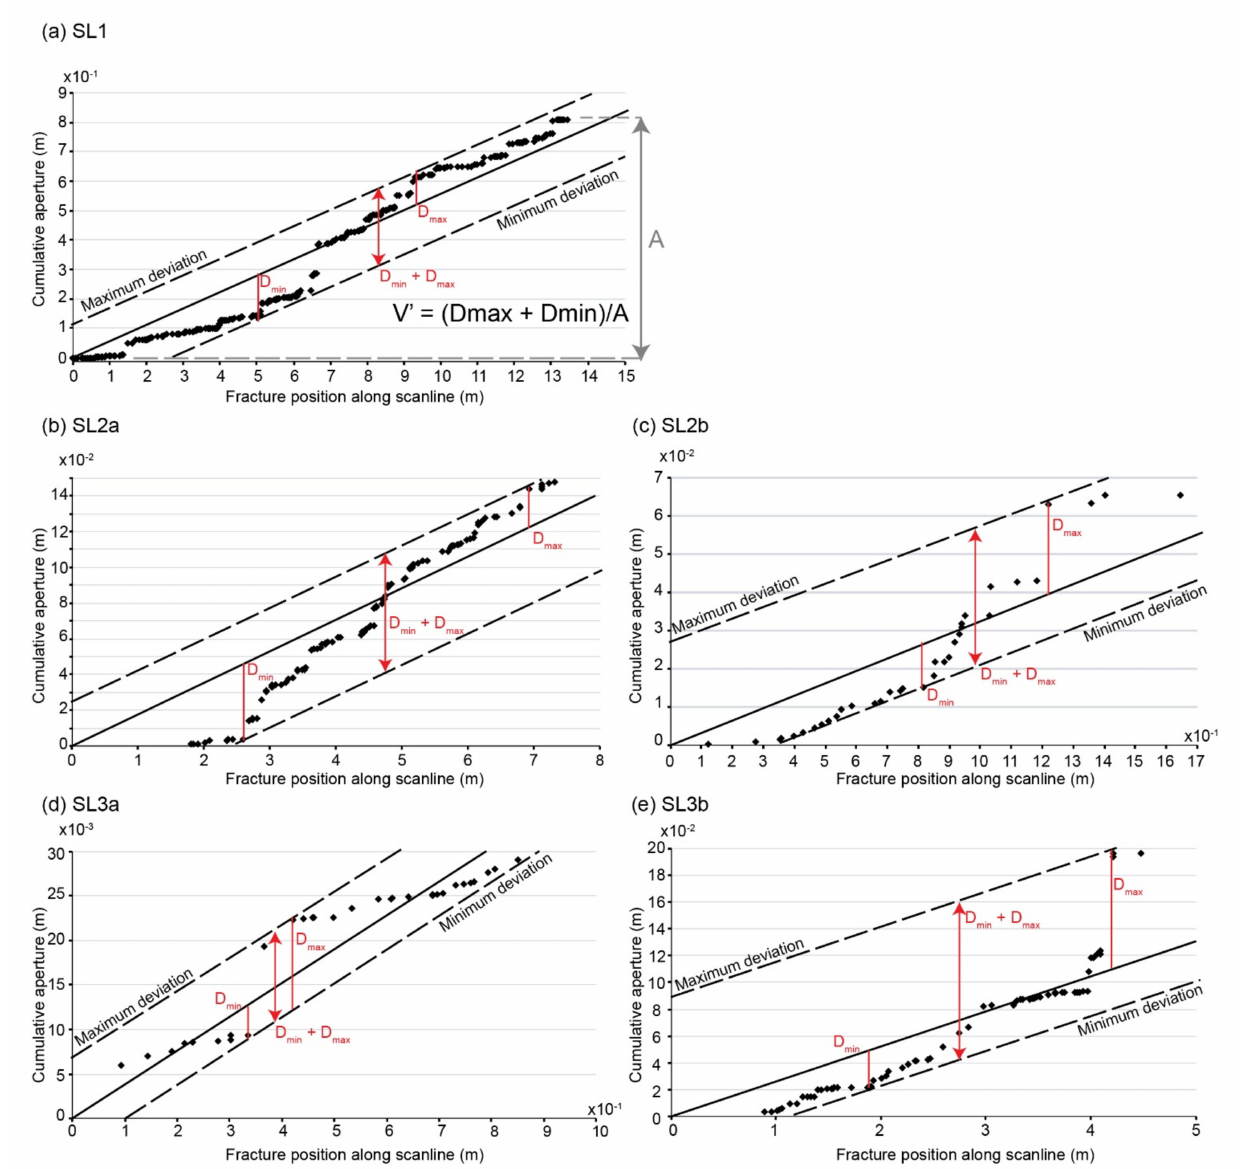
Figure 10. Plot of the sum of all apertures (cumulative fracture aperture) intersected along a scanline to show V (cid:48) for linking the origin to the cumulative aperture to the end of the scanline (for further explanations, see [20,30]). D max and D min correspond to the maximum and minimum difference between the cumulative aperture and the uniform strain line, respectively. V (cid:48) quantifies the heterogeneity of the strain distribution, varying from 0 (uniform distribution) to 1 (maximum possible